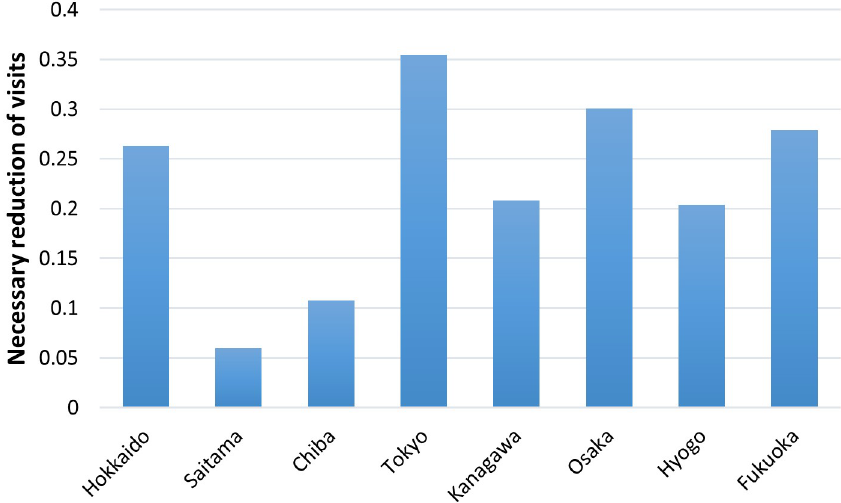
Fig 6. Necessary reduction level of visits to hospitality sector businesses to achieve R(T) < 1 for “80% of days”.